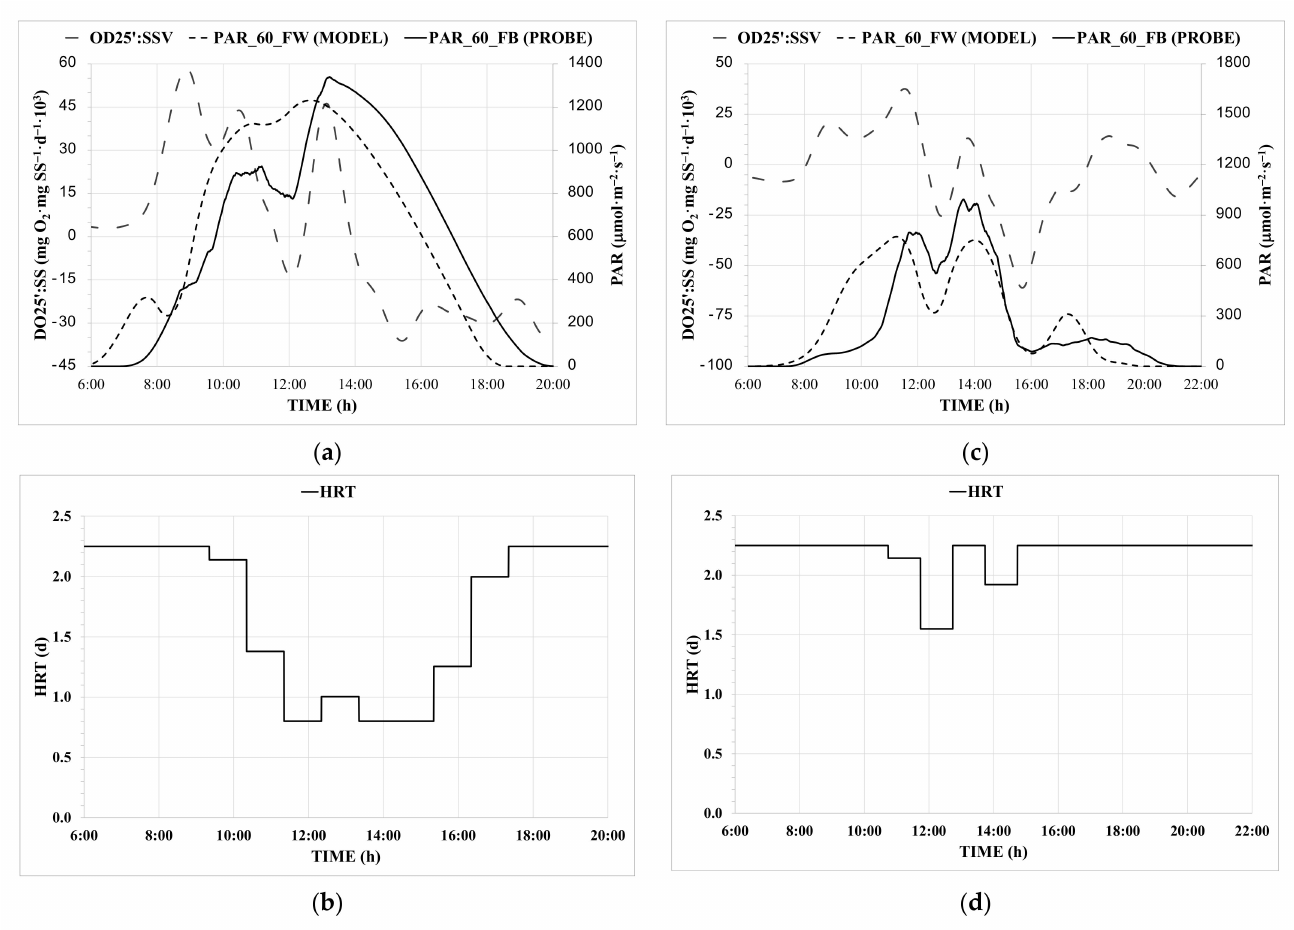
Figure 7. Hourly HRT controller action. Day 16: ( a ) Input variables; ( b ) Output settings; Day 40: ( c ) Input variables; ( d ) Output